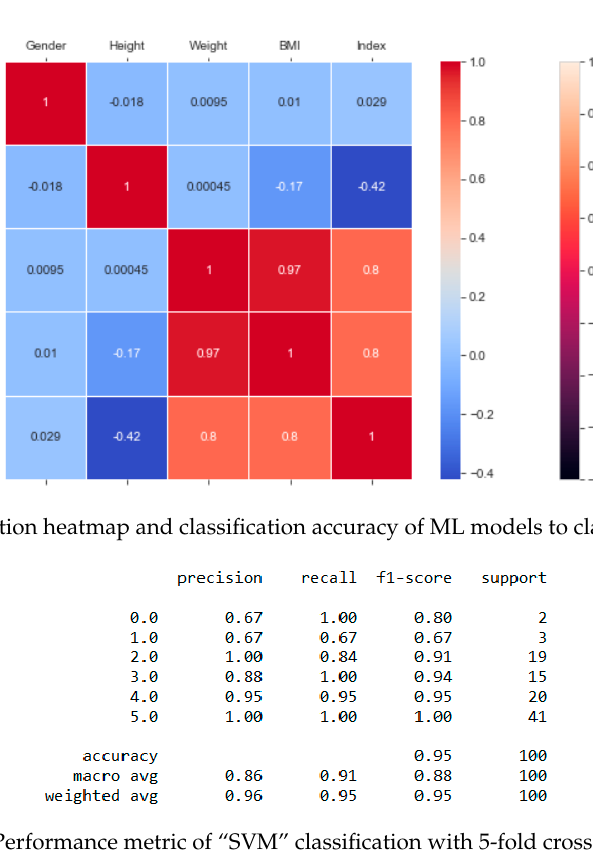
Figure 4. Sensors 2020 , 20 , x FOR PEER REVIEW